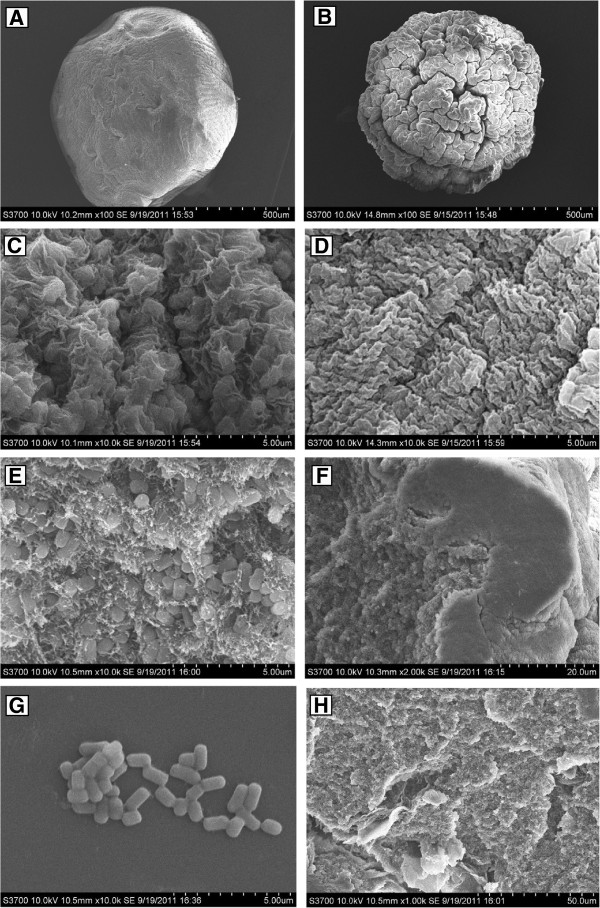
Scanning electron micrographs of the Ca-alginate and alginate–chitosan beads containing Acetobacter cells. The surface view of Ca-alginate (A, ×100; C, ×10.0 k) and chitosan-coated beads (B, ×100; D, ×10.0 k); the inside view of Ca-alginate (E, ×10.0 k); cross-section of at the edge of an alginate-chitosan bead showing the peripheral membrane structure (F, ×2.00 k); free cells (G, ×10.0 k) and inside view of alginate-chitosan (H, ×1.00 k); Voltage: 10.0 kV.